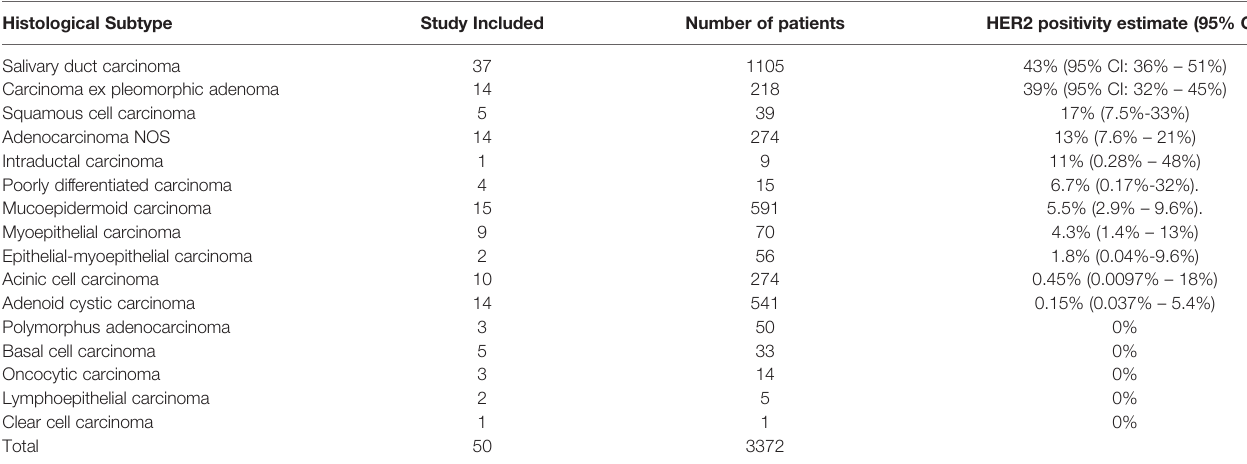
TABLE 2 | Summary of results.